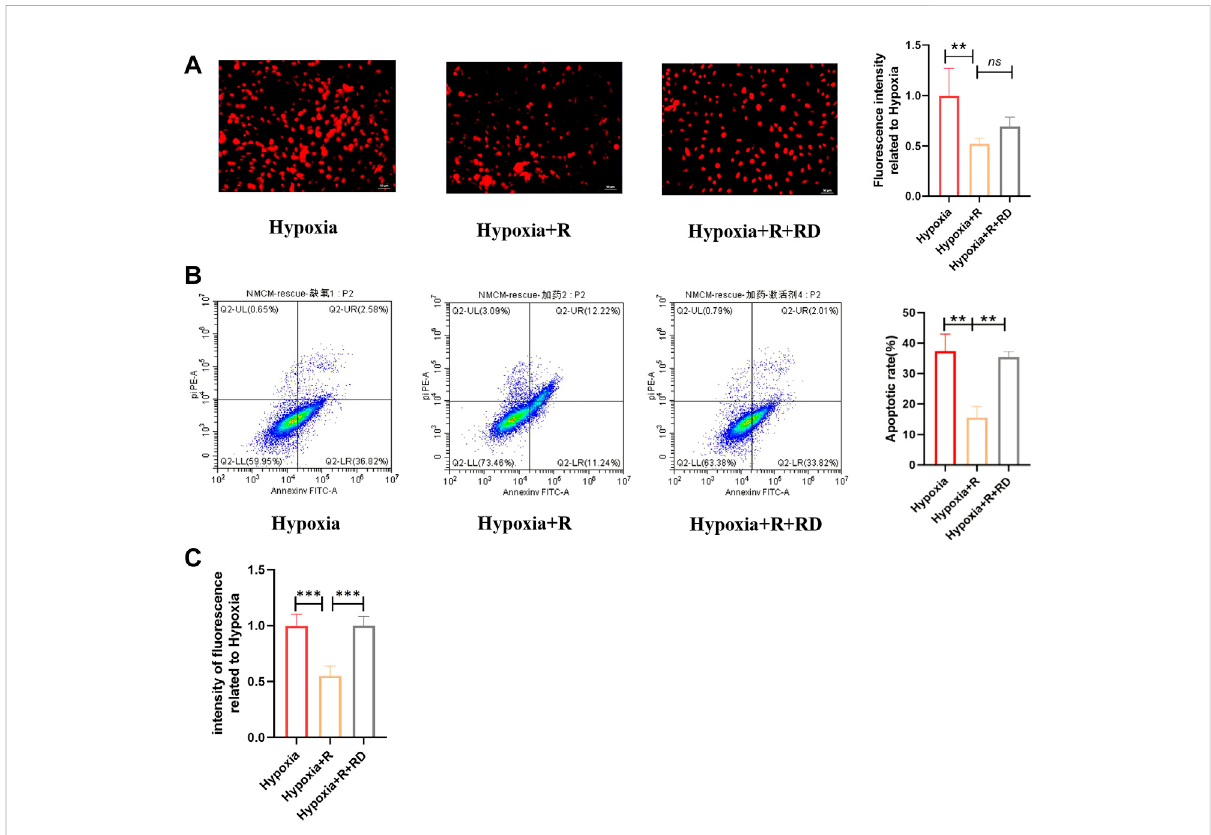
FIGURE 9 RSYRD can reduce ROS productionto reduce theapoptosis rate ofNMCMs. (A) ROS fl uorescence intensity ofNMCMs in three groups (mean ± SD, n = 3). (B) Apoptosis ratesof NMCMs in three groups (mean ± SD, n = 3). (C) ROS fl uorescence intensity ofNMCMs in three groups detected